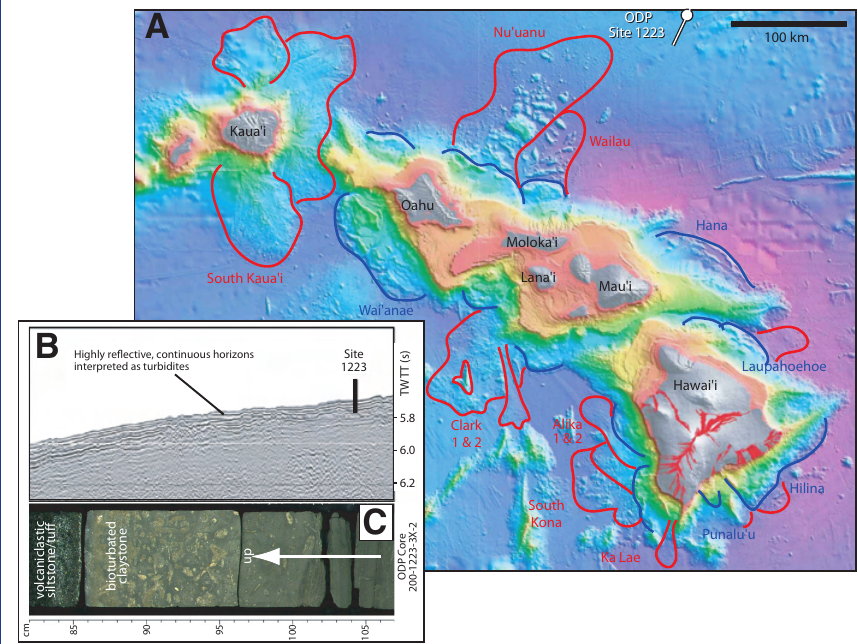
Figure 8. [A] Landslides and slumps around Hawaii (mapped by Moore et al., 1989 and more recent work from Tom Sisson). Red outlines debris avalanche fields; blue outlines slumps; islands are in gray. Location of seismic line and ODP Site 1223 indicated in white. Bathymetry from Eakins et al. (2004). [B] Portion of reflection profile across ODP drill site, showing multiple reflective turbidite horizons. [C] Representative drill core from ODP Site 1223, showing volcaniclastic sandstone/tuff unit overlying bioturbated claystone, with intervening erosional boundary. Figures B and C modified from Shipboard Scientific Party